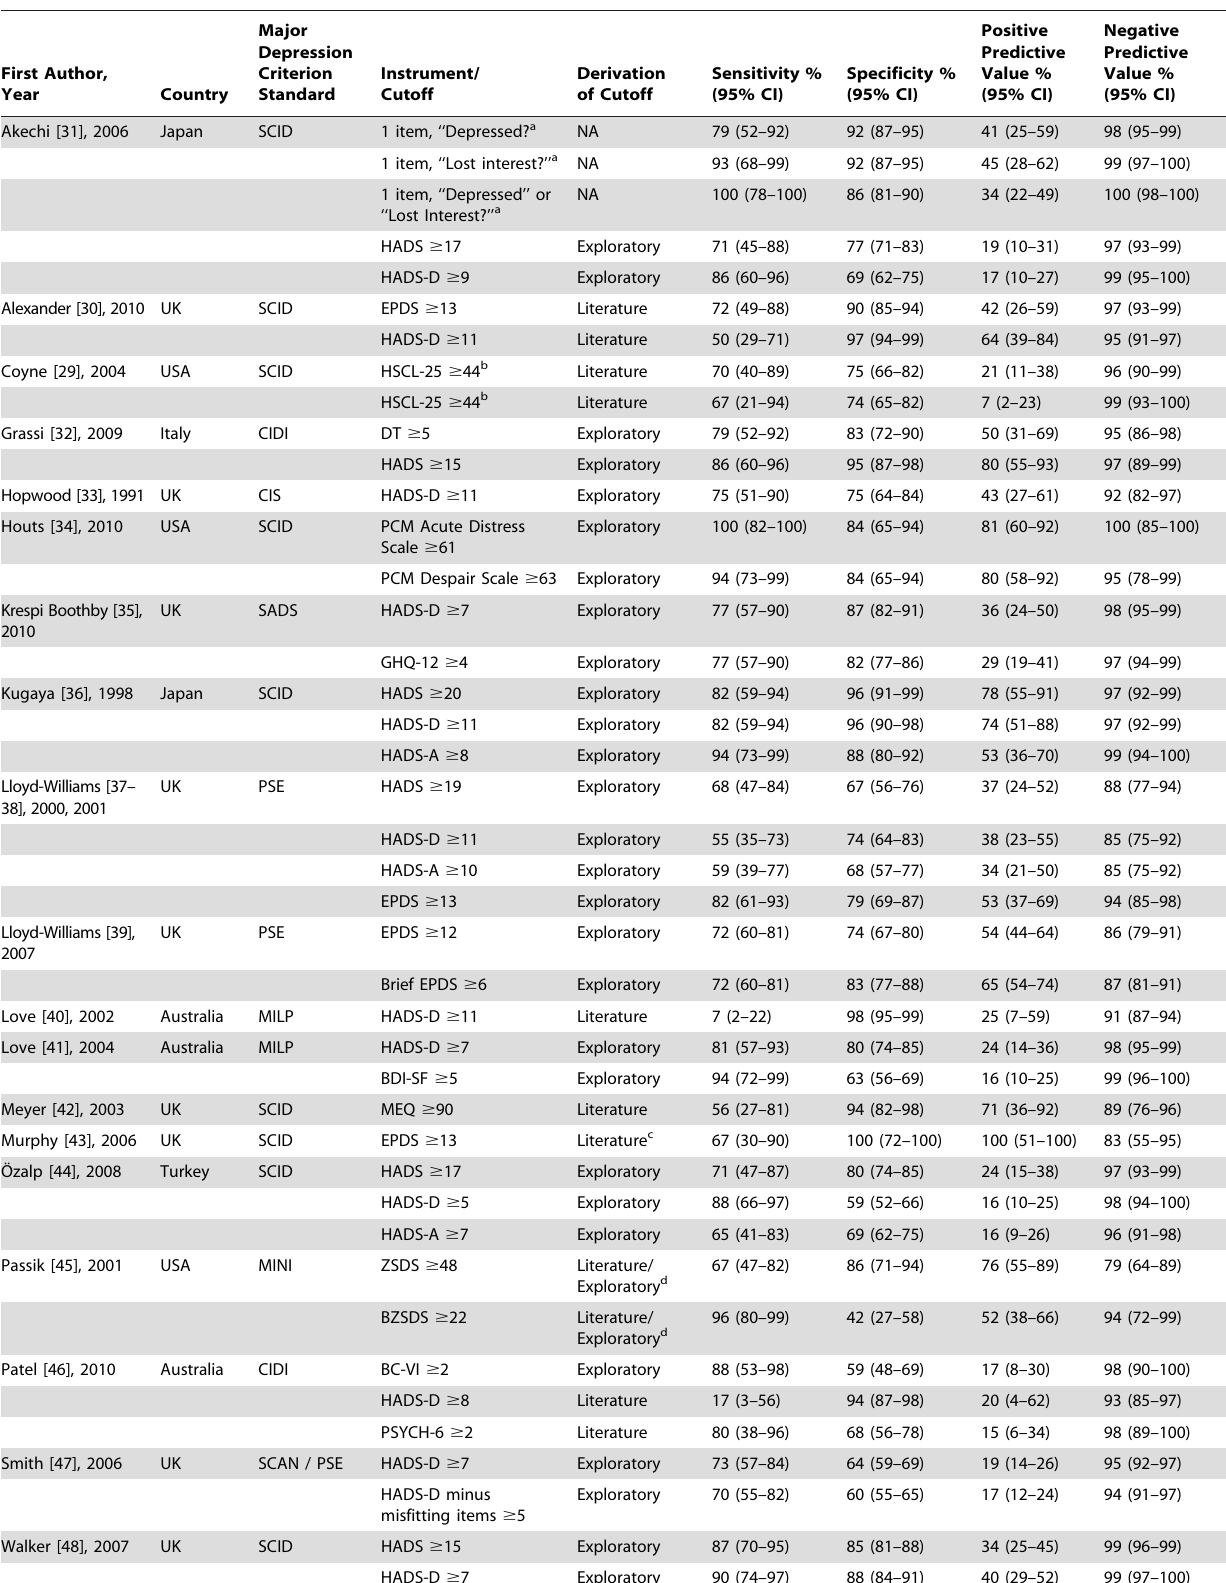
Table 2. Results of Diagnostic Accuracy of Depression Screening